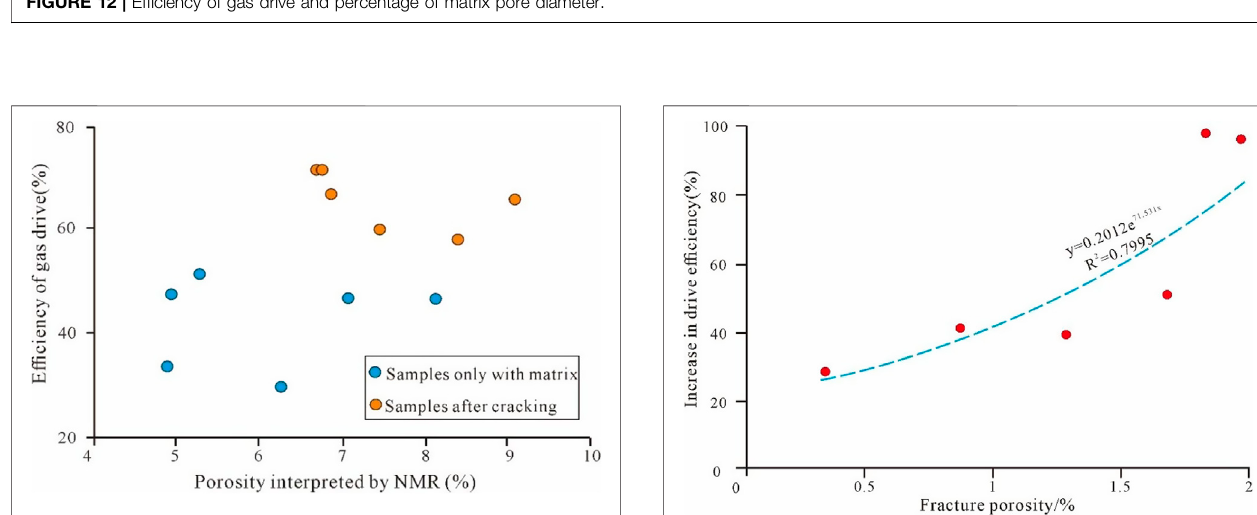
FIGURE 12 | Ef fi ciency of gas drive and percentage of matrix pore diameter.